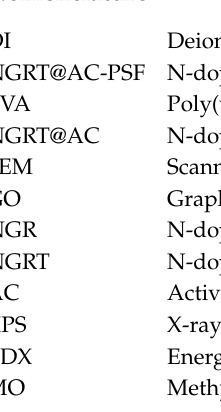
Figure 13. The antifouling indices of all membranes under ( a ) dark, ( b ) sunlight, and ( c ) UV irradiation.